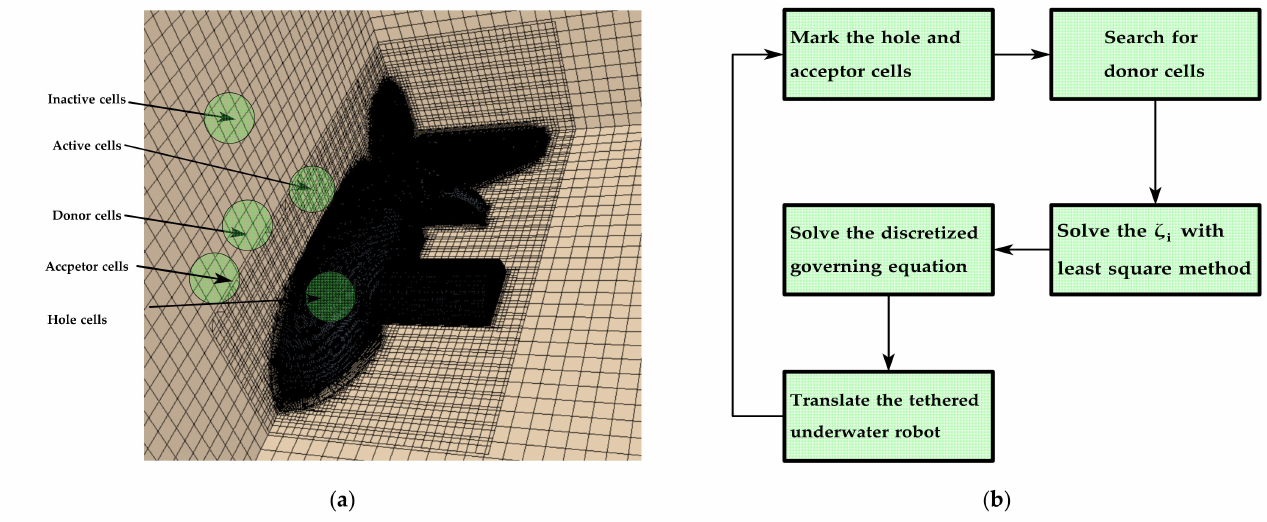
Figure 2. The diagram of the overlapping grid and the procedure of numerical simulation applied the overlapping grid: ( a ) the cells of the tethered underwater robot’s overlapping grid; ( b ) the procedure of numerical